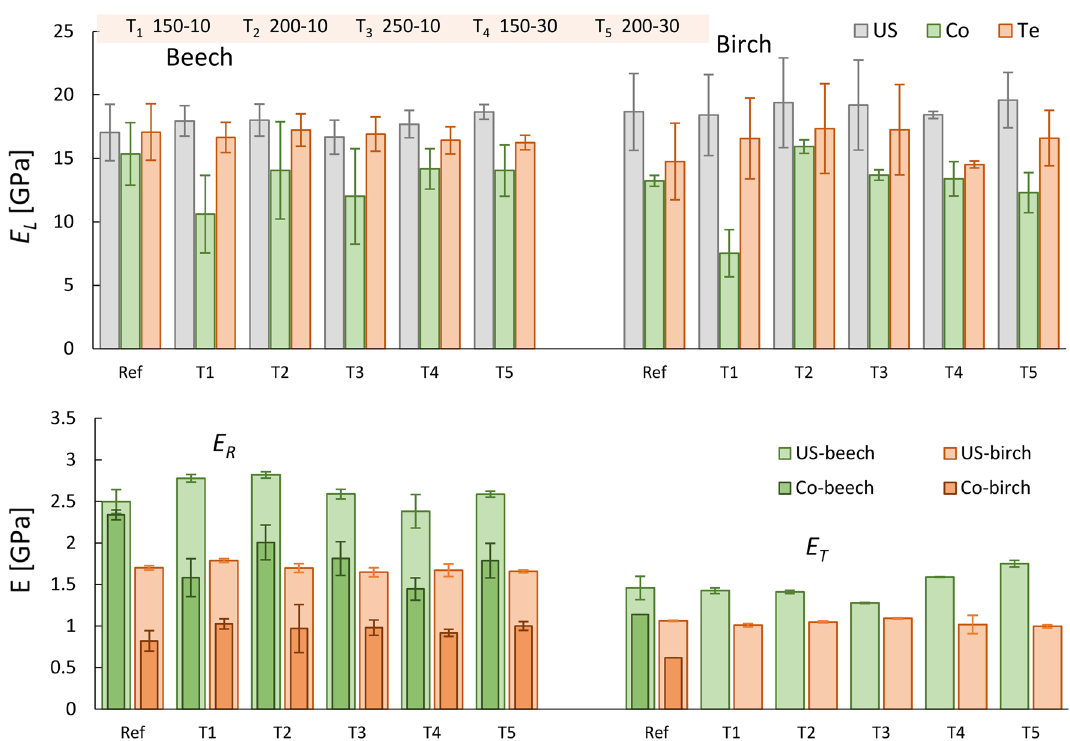
Figure 9. Mean values for the Young’s moduli of reference and heat-treated beech and birch obtained by ultrasound (US) and quasi-static tests (Co: compression; Te: